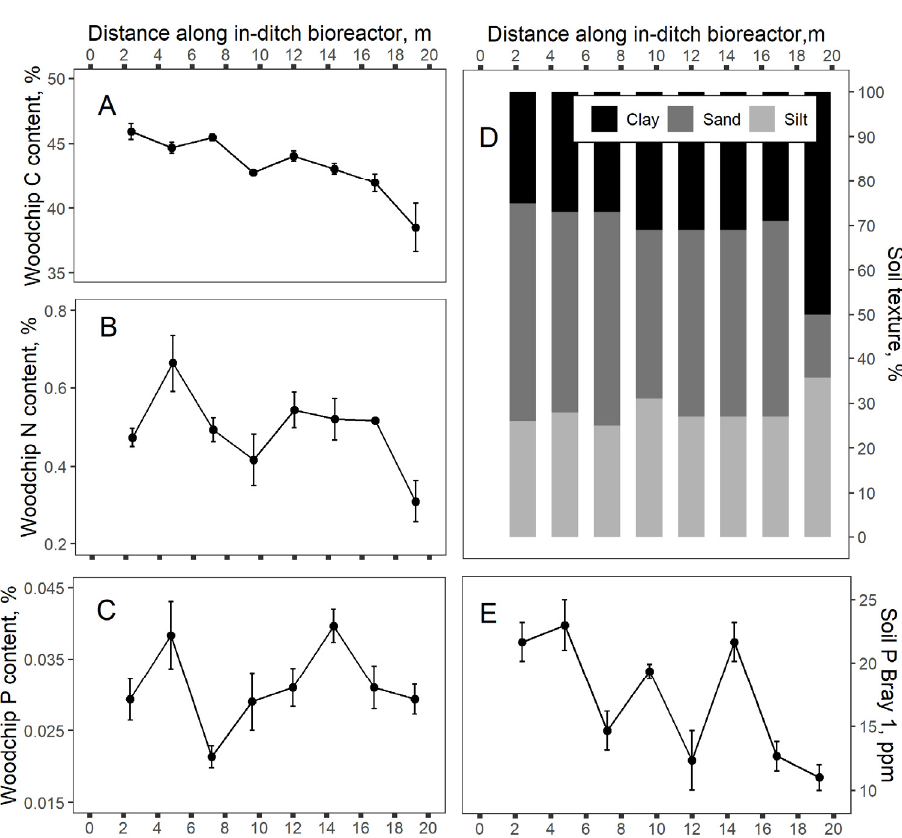
Figure 5. In-ditch bioreactor woodchip carbon ( A ), nitrogen ( B ), and phosphorus ( C ) content as well as soil texture ( D ) and soil Bray-1 phosphorus ( E ) taken from samples collected every ~2.4 m, along the in-ditch bioreactor 25 months after construction. Plotted points are the mean (n = 3) with error bars showing standard deviation for all analyzes except soil texture (n =